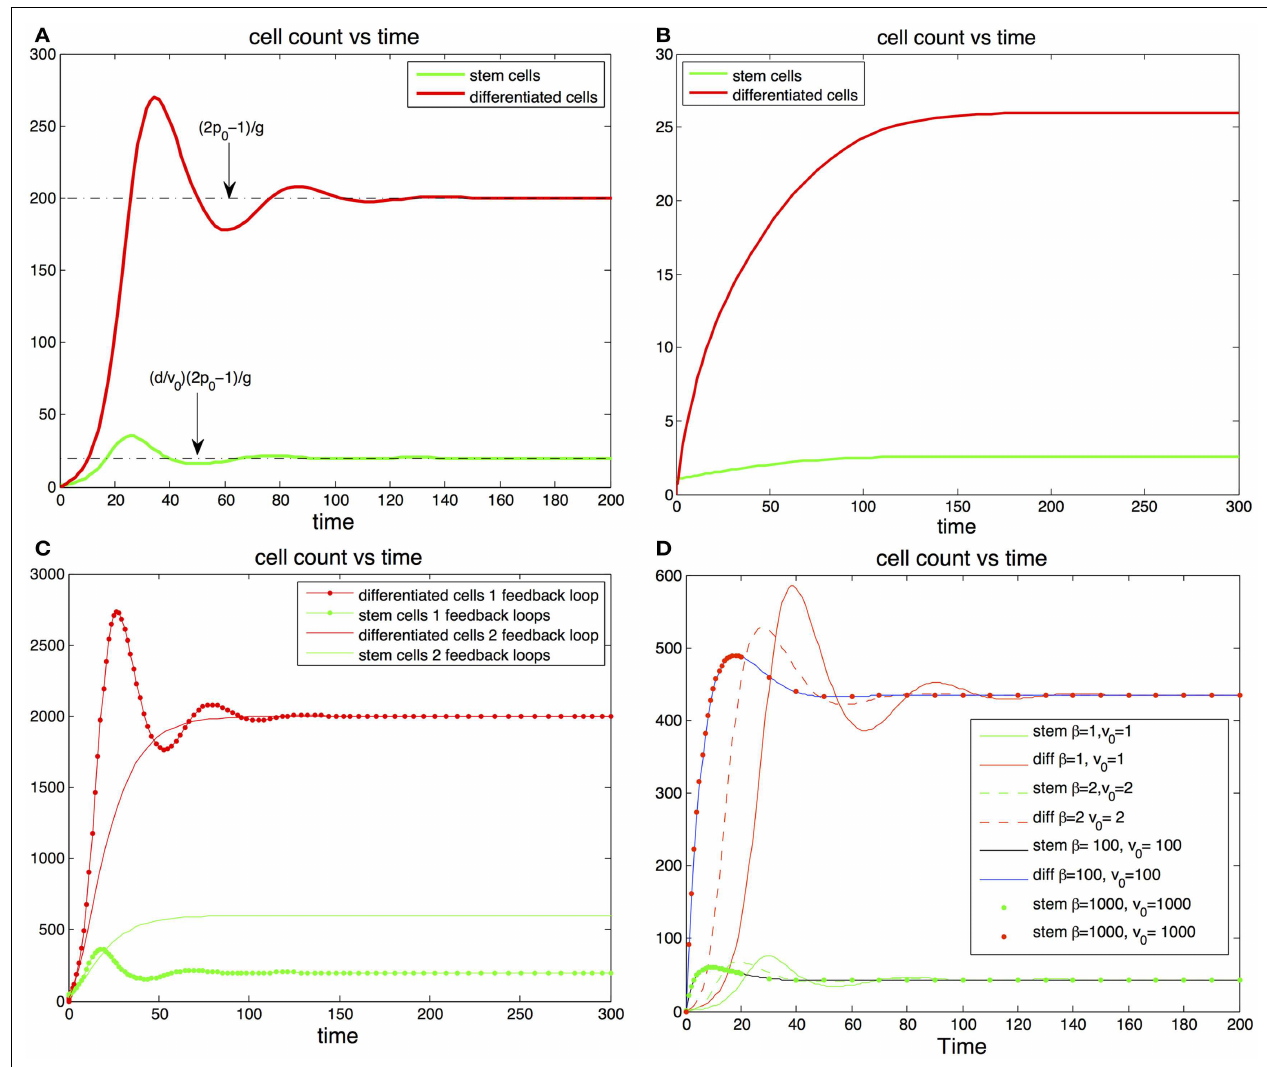
independent of feedback on the division rates.The steady state number of stem cells increases when the number of feedback loops increase from one to two.The addition of feedback in the division rate dampens or altogether eliminates the oscillations. (D) Fitting fixed steady state values of stem cells and differentiated cells values with different levels of feedback inhibition in the division rate.The stronger the feedback signal in the division rate the smoother the transition the equilibrium transition to